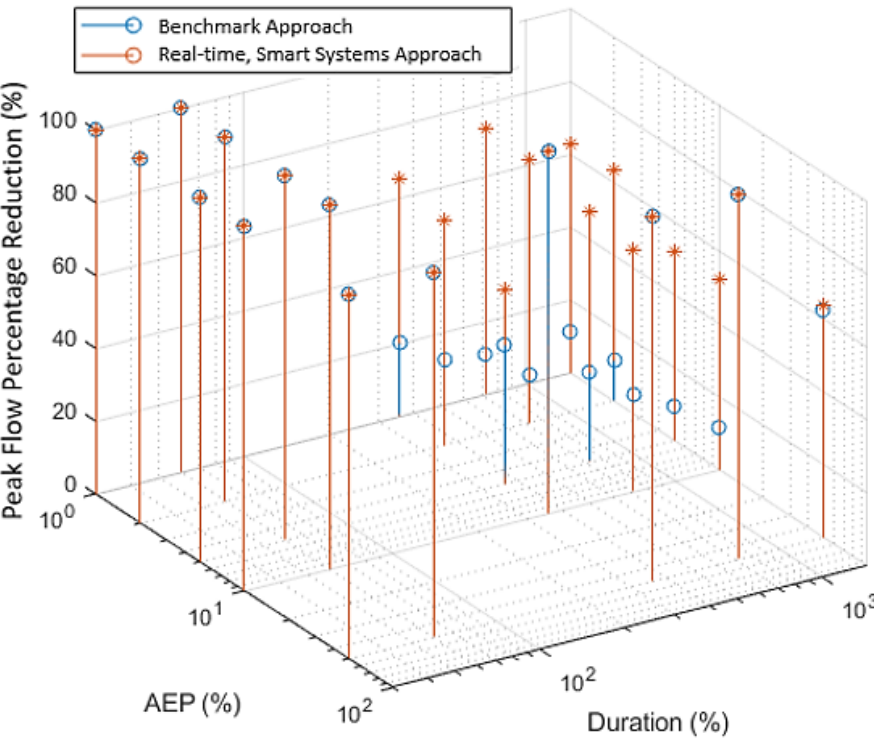
Figure A4. Percentage peak flow reduction of benchmark tanks and real-time, smart tank systems for a range of durations and AEPs with 2 × 10 m 3 tanks in Melbourne.